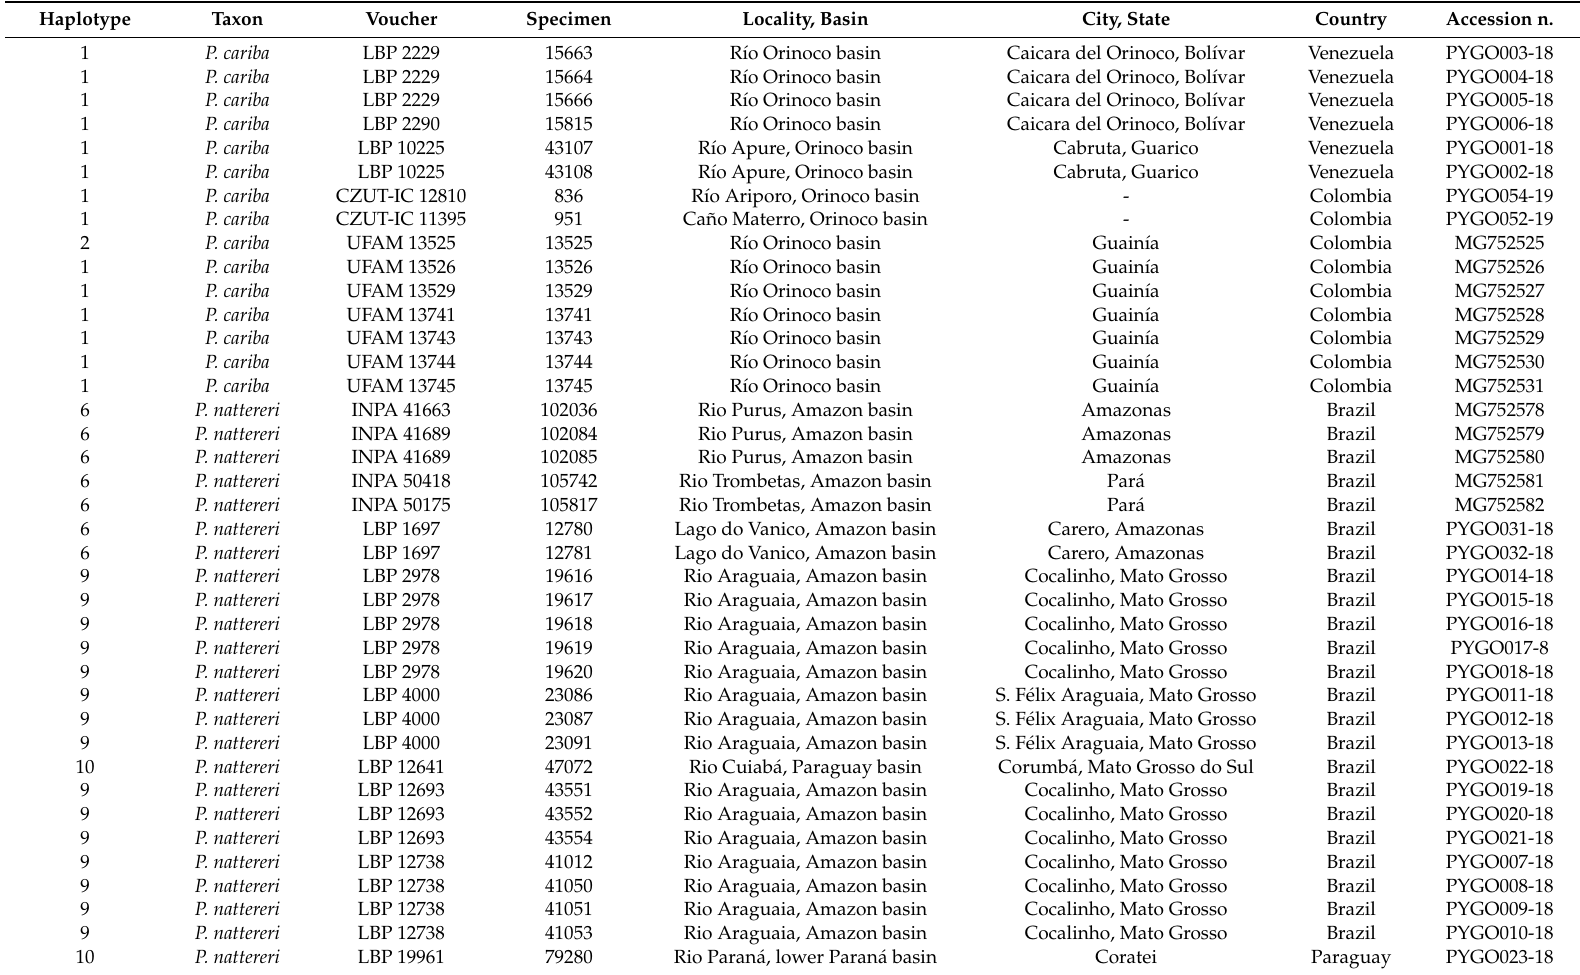
Table A1. Voucher, locality information and BOLD or Genbank accession numbers of the analyzed specimens of Pygocentrus